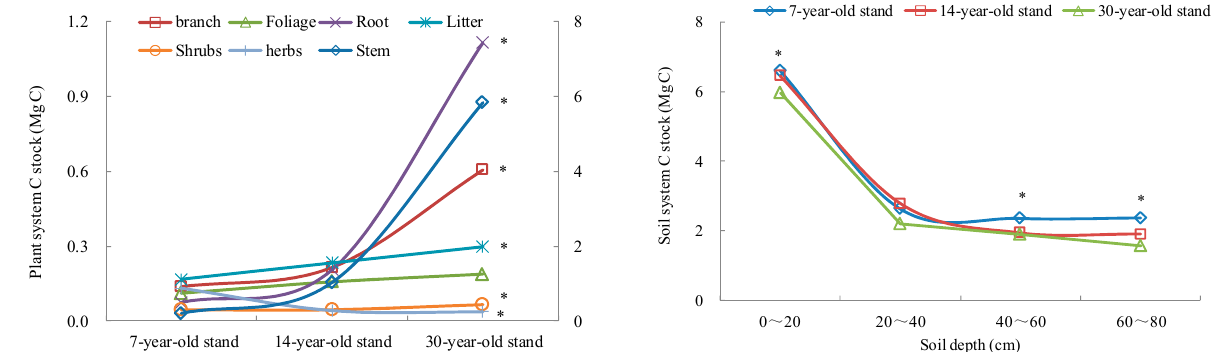
Figure 1. Variability of carbon stocks across a chronosequence of Masson pine plantations. Significance level: *, p < 0.05.